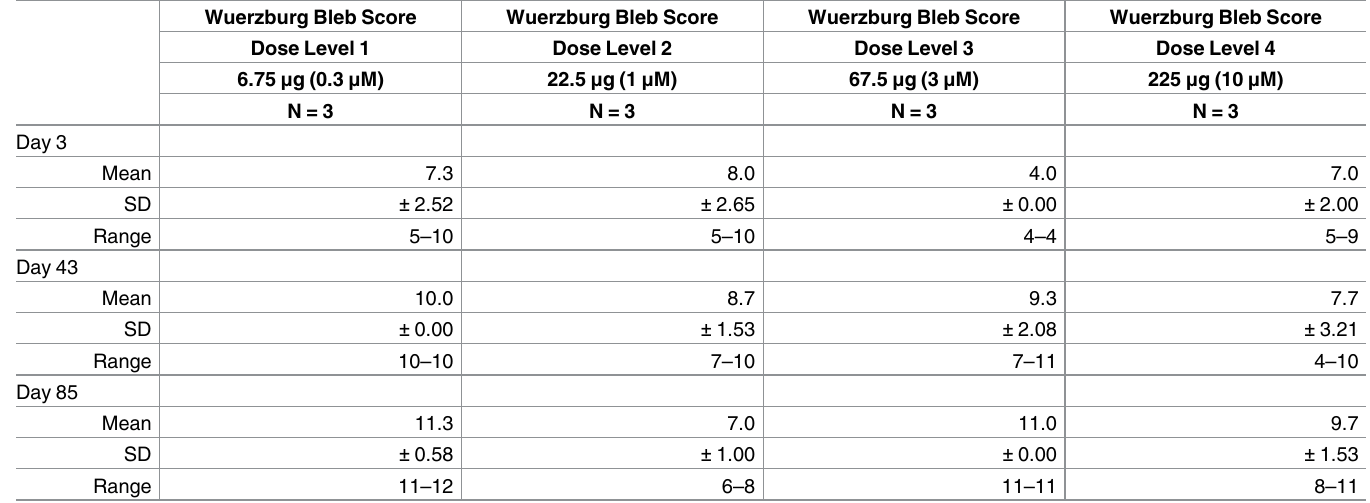
Table 5. Bleb filtering and morphology evaluation (Wuerzburg bleb classification Score).